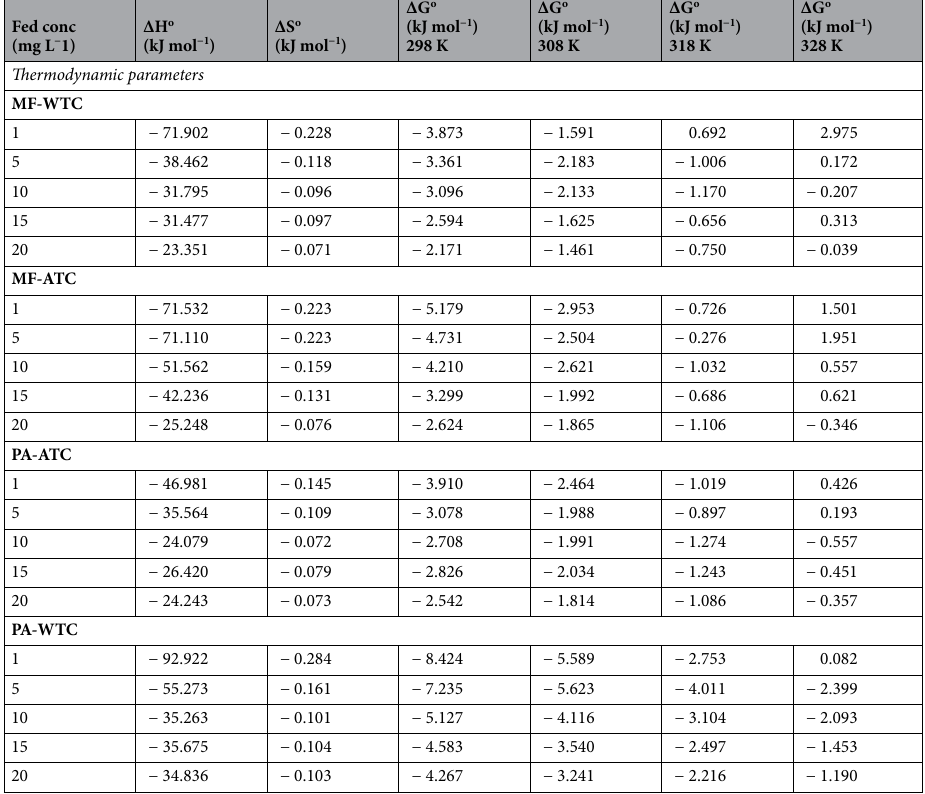
Table 2. Thermodynamic parameters for the adsorption of MF and PA on WTC and ATC at a temperature range of 298–328 o